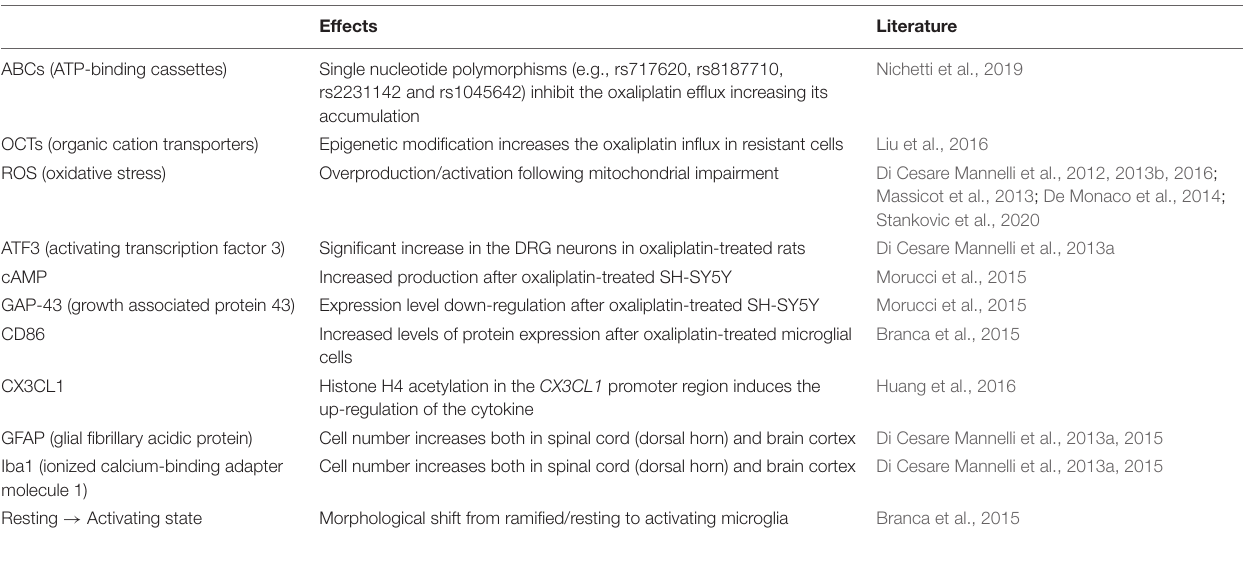
TABLE 1 | Main signaling pathways involved in oxaliplatin-dependent